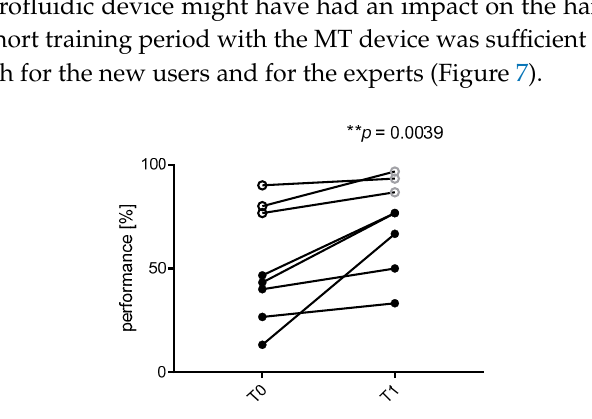
Figure 7. Pilot study 2. Performance of the MT device as a trainer. Level of experience in handling microfluidic supports, as measured with OrganoPlate ® 2-lane, before (T0) and after (T1) 3 slots of 30-min continuous training with the MT device. The filled circles are relative to new users, the empty circles are relative to the experts ( n = 8, ** p < 0.005, Wilcoxon test of paired analysis).